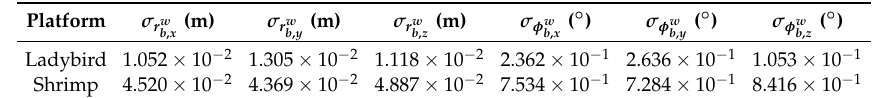
Table 2. Median navigation system uncertainties as 1 standard deviation.